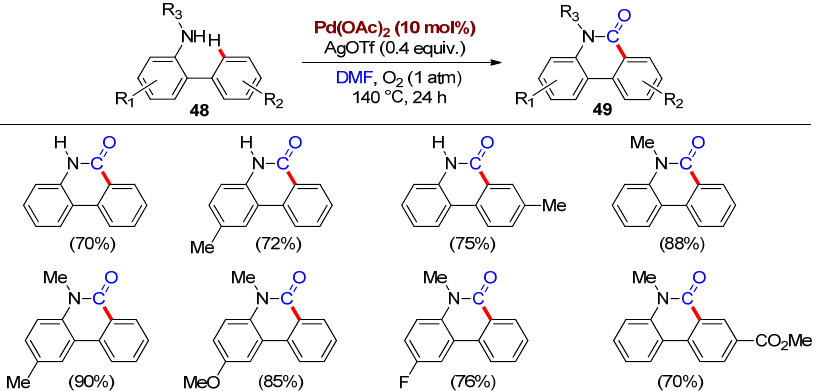
Scheme 19. Synergistic Pd/Ag-catalyzed carbonylative cyclization of N -methyl 2-arylanilines 48 with